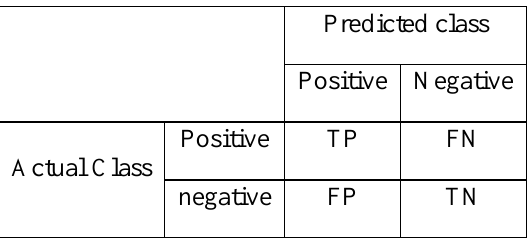
Table 1 Confusion Matrix (Branco et al.